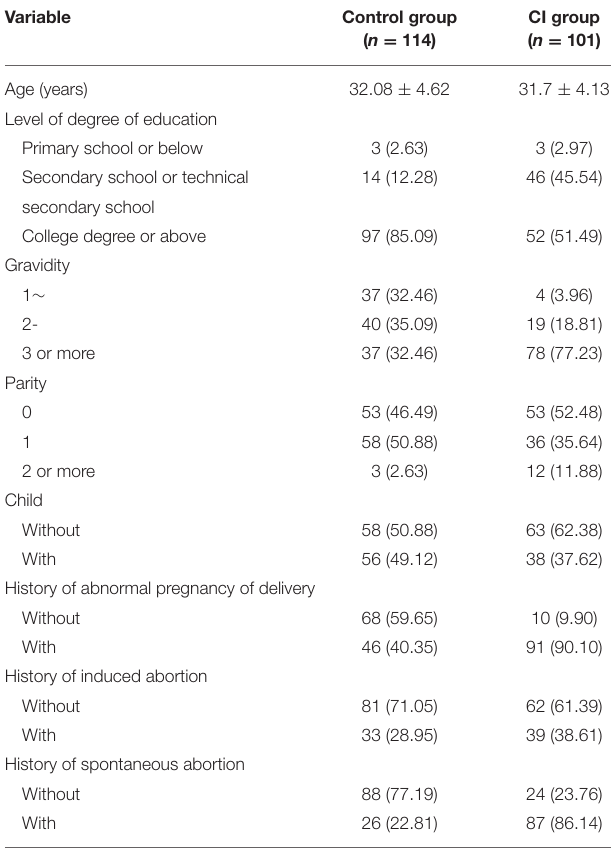
TABLE 1 | General information of the included